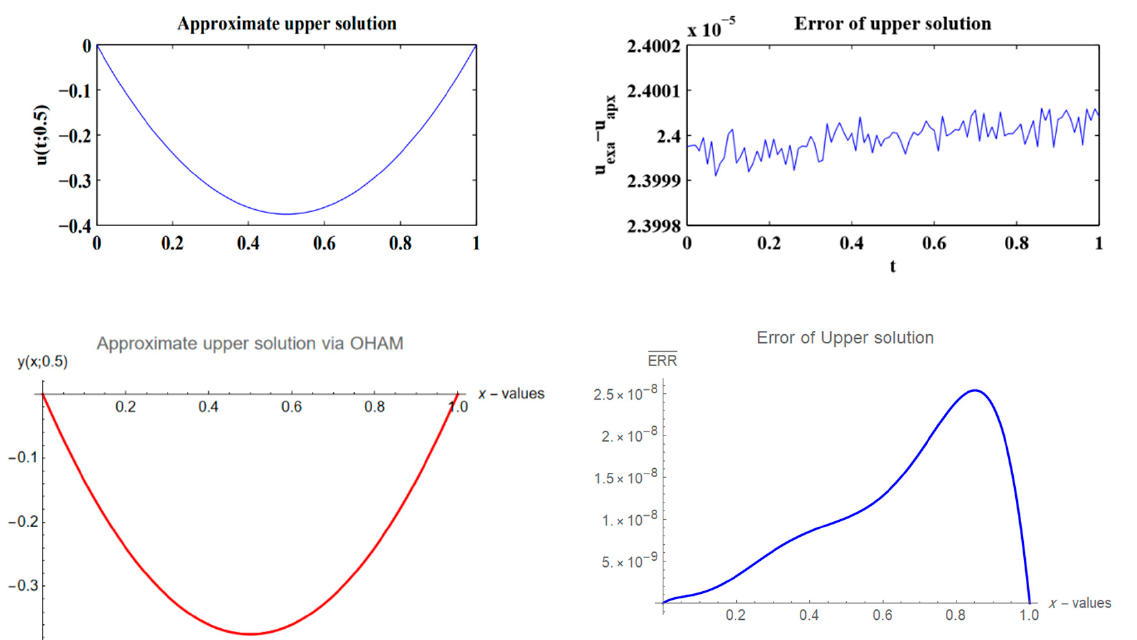
Figure 4. Comparison of the upper approximate solution for Equation (31) using the fifth-order FF-OHAM and the fifth-order SCM for α = 0.5 and ∀ x ∈ [ 0,1 ] .